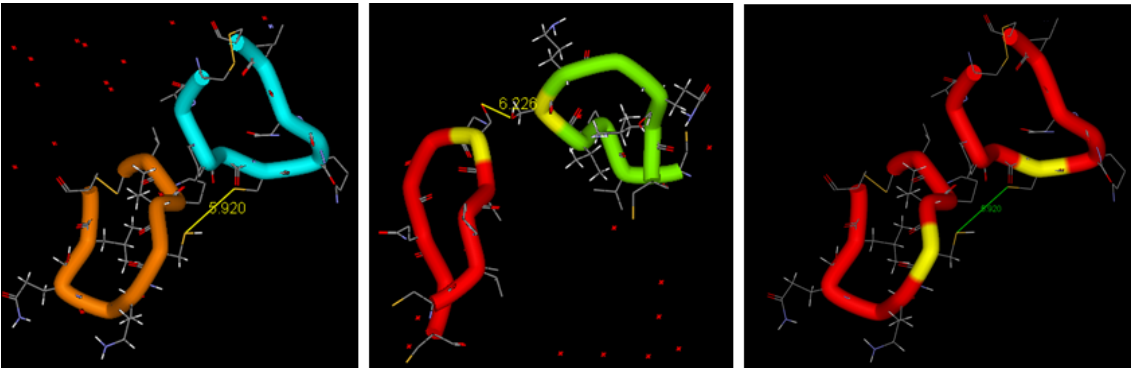
Figure 3. Design of peptide mimetic dimers of neurotrophic factors based on the structure of the loop 2 in heterodimer configurations BDNF/NGF ( left and middle ) and in a BDNF homodimer ( right ). The cysteine bridges and the interloop distances are